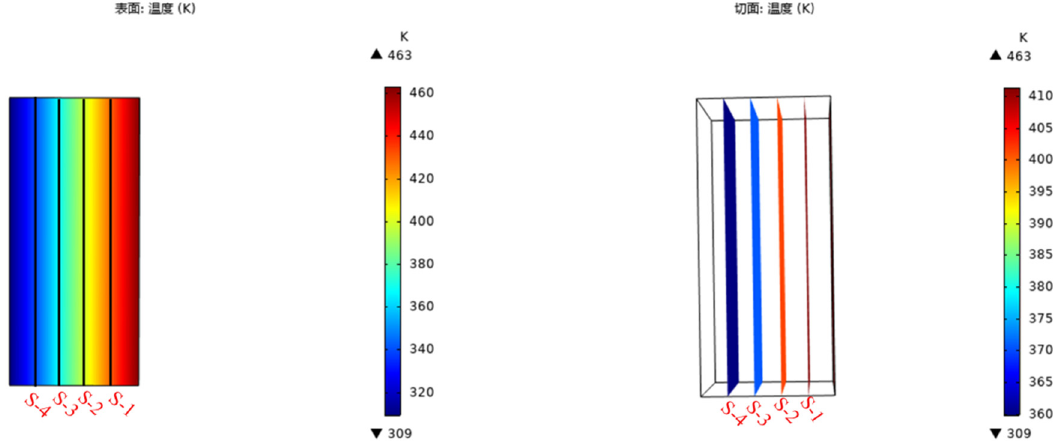
Figure 6: Simulation temperature results of di ff erent isothermal planes of PP composites.